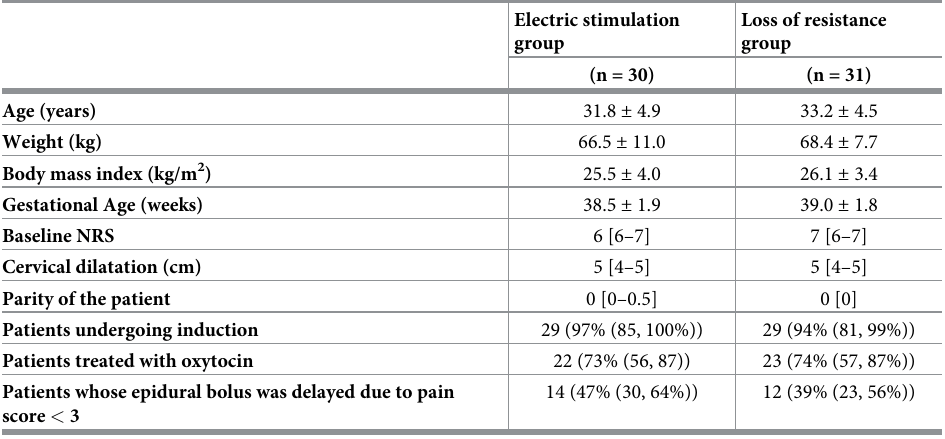
NRS: numerical rating scale of 0 to 10. Data are presented as mean ± standard deviation, median [interquartile range] or number (% (95% confidence interval)).